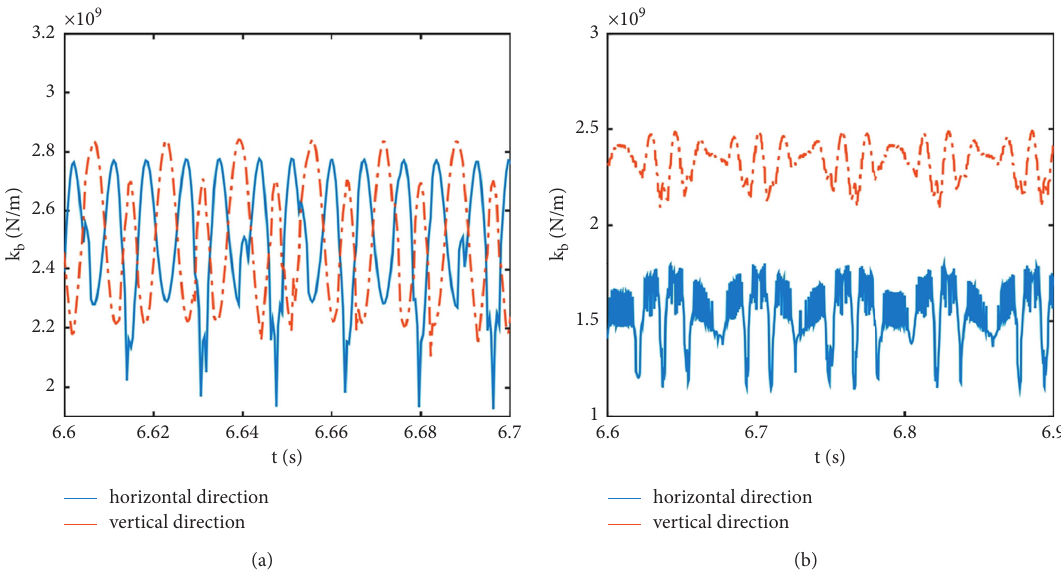
Figure 3: The time-varying stiffness feather of the intershaft bearing. (a) f